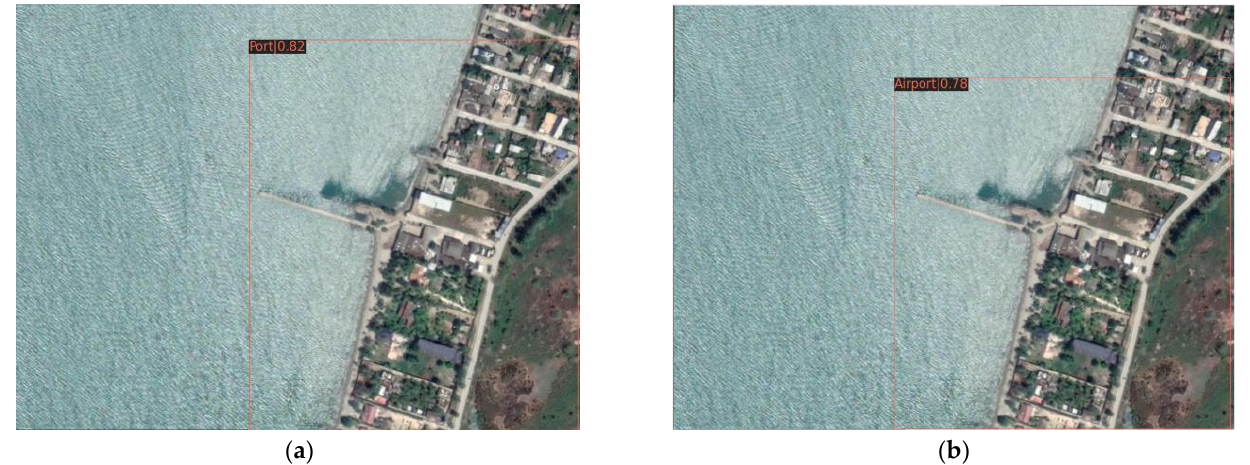
Figure 8. Airport prediction comparison: ( a ) Swin-HSTPS airport forecast results (confidence 0.99); ( b ) Swin Transformer airport forecast results (confidence 0.95).